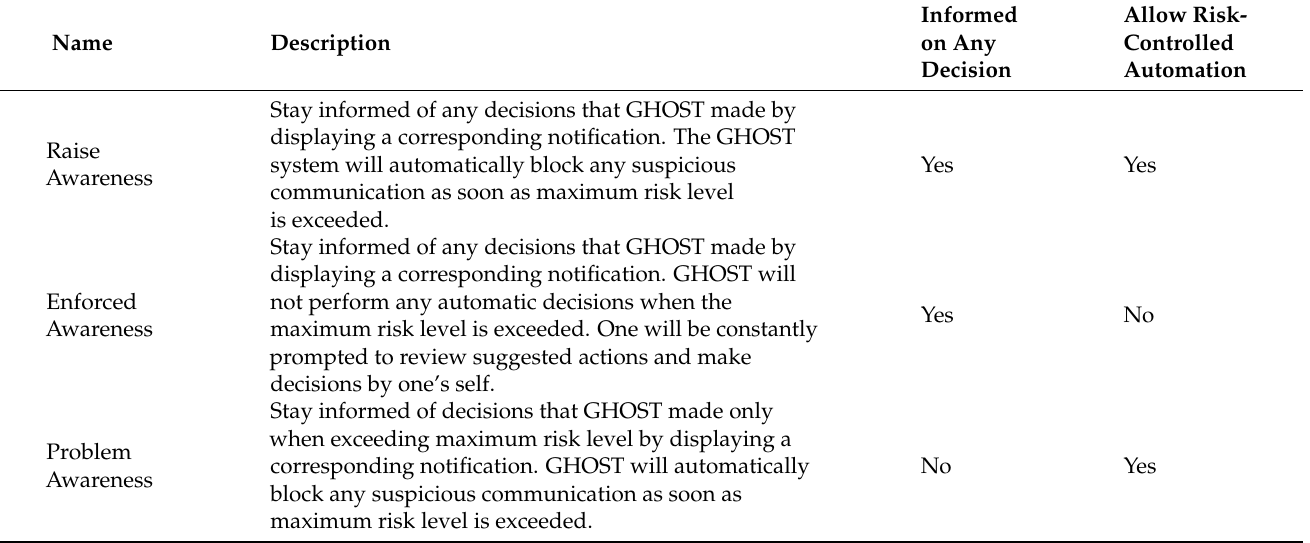
Table 8. Awareness preferences.